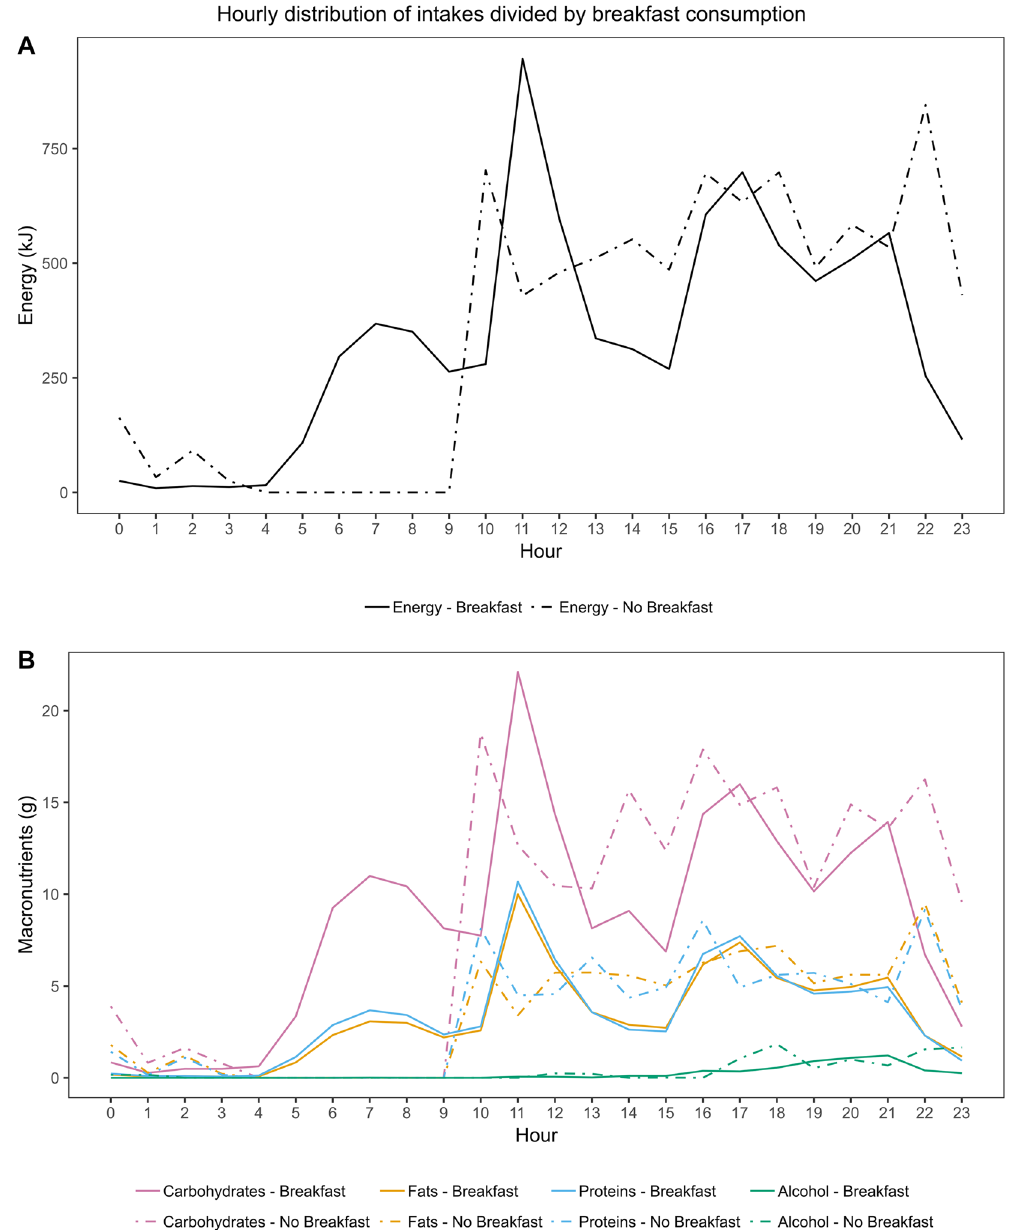
Figure 2. Hourly distributions of energy and macronutrient intakes divided by breakfast consumption. ( A ) Energy intake by breakfast consumption. ( B ) Macronutrient intakes by breakfast